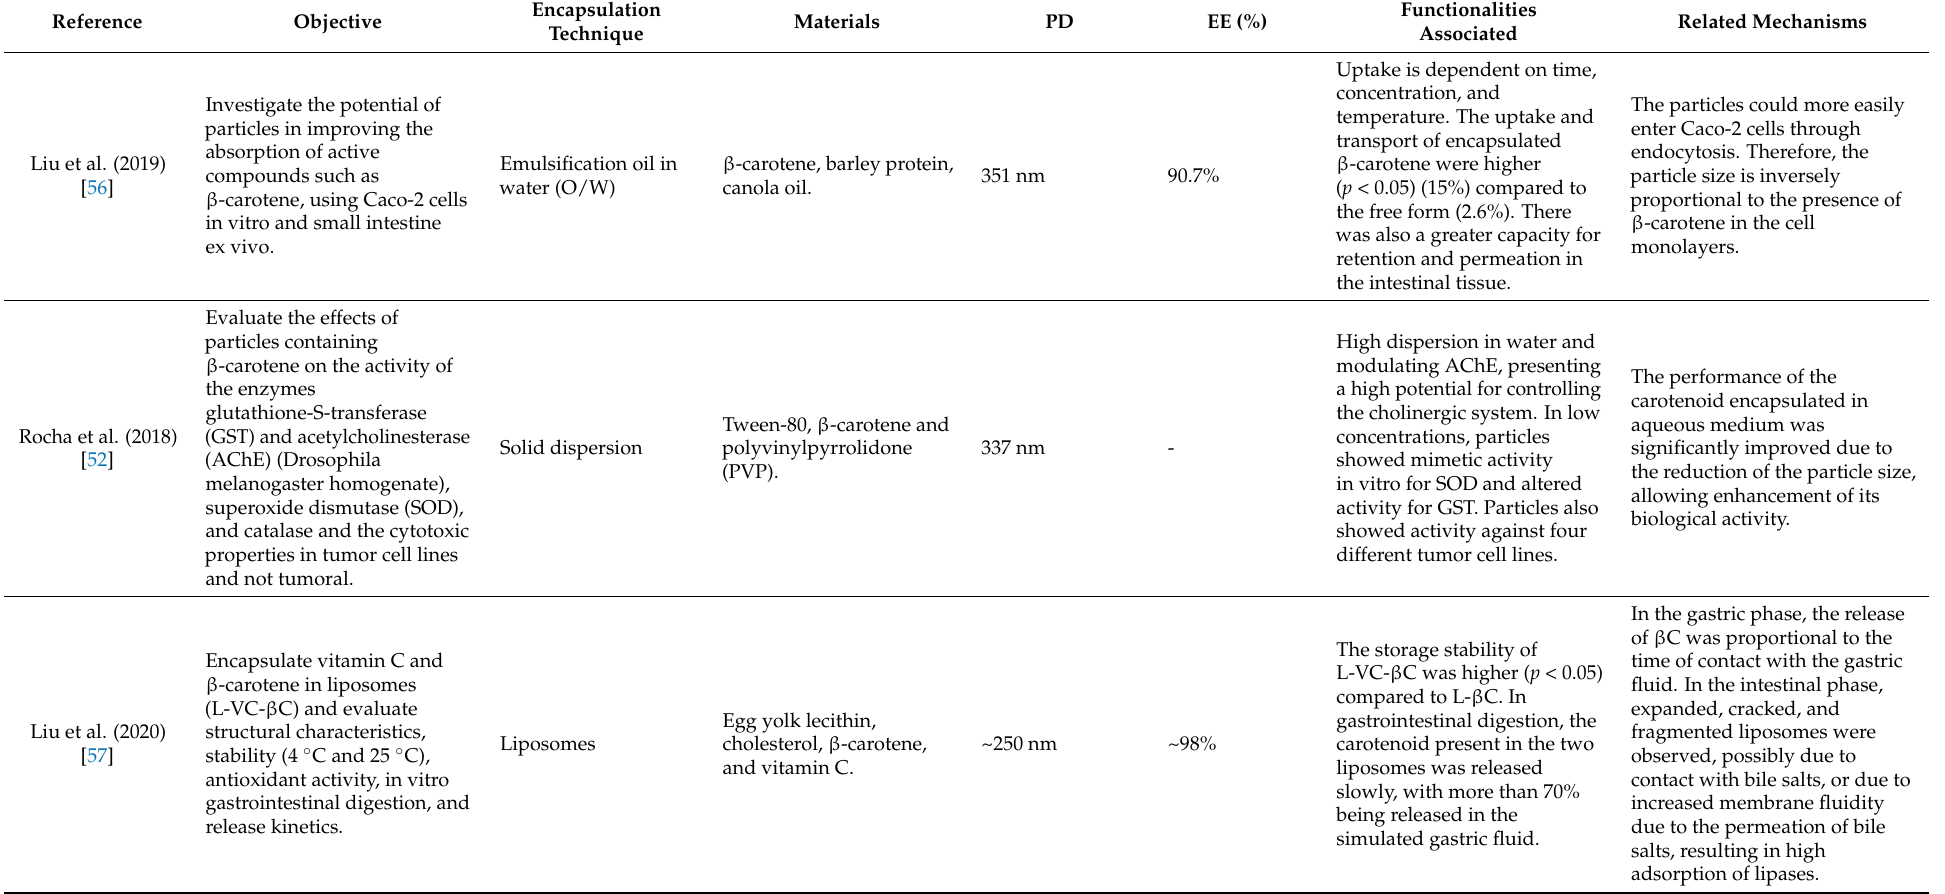
Table 2. Encapsulation of vitamin A and precursors with provitamin A